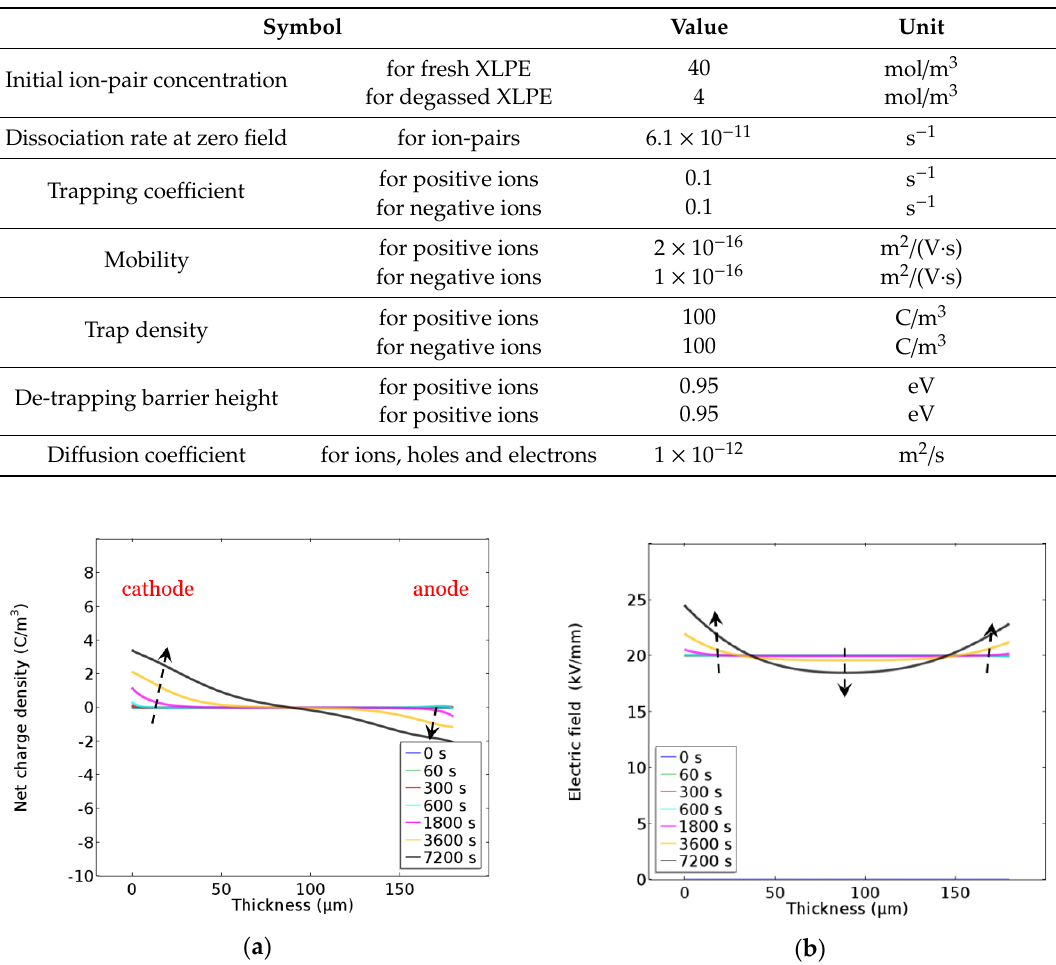
Table 2. Parameters used for simulating space charge in XLPE at room temperature.